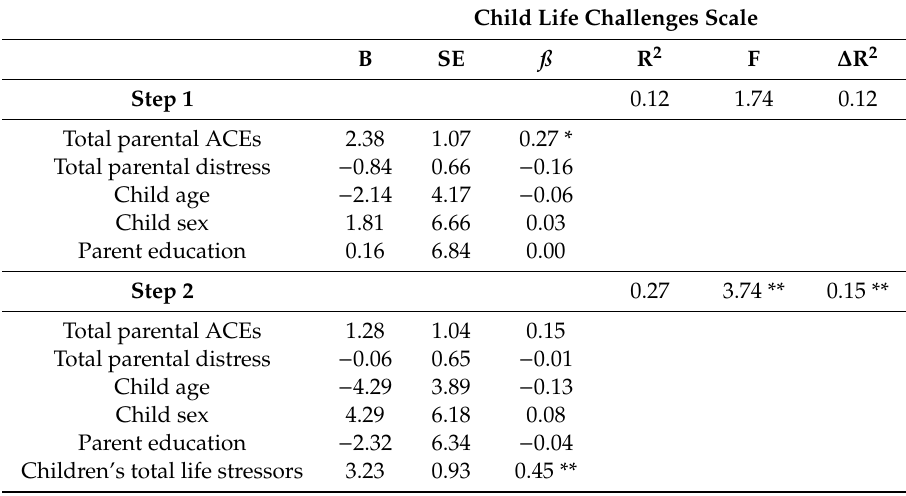
Table 2. Regression for CLCS scores (n =